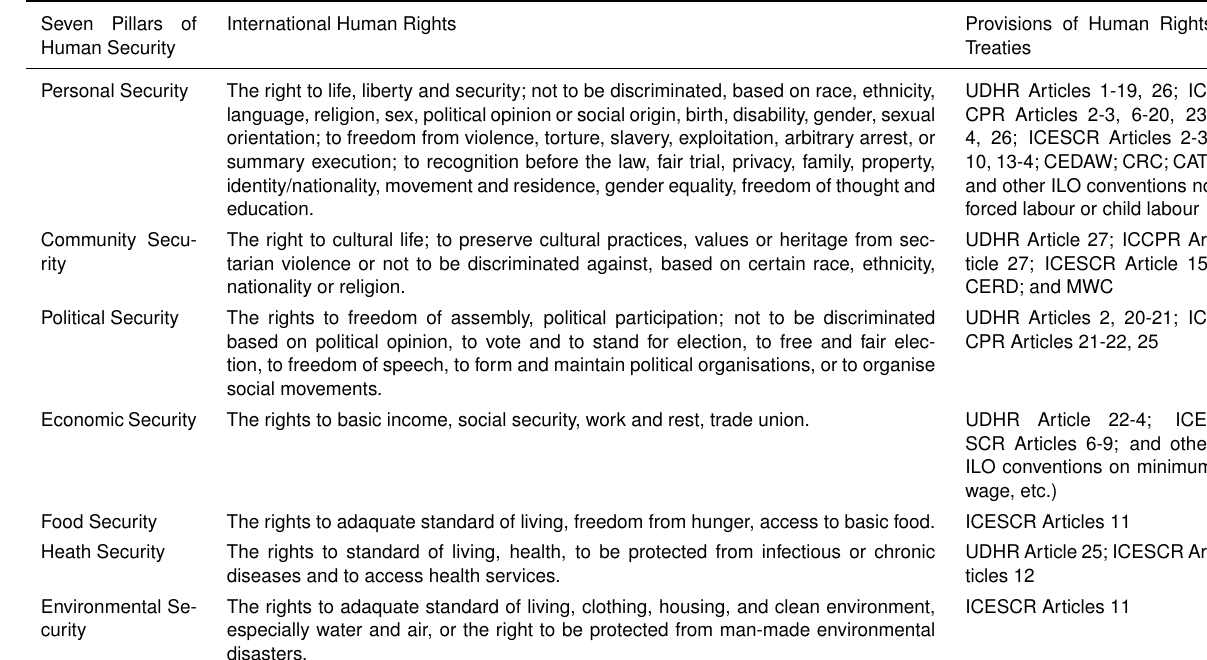
Table 2. Human Security and Human